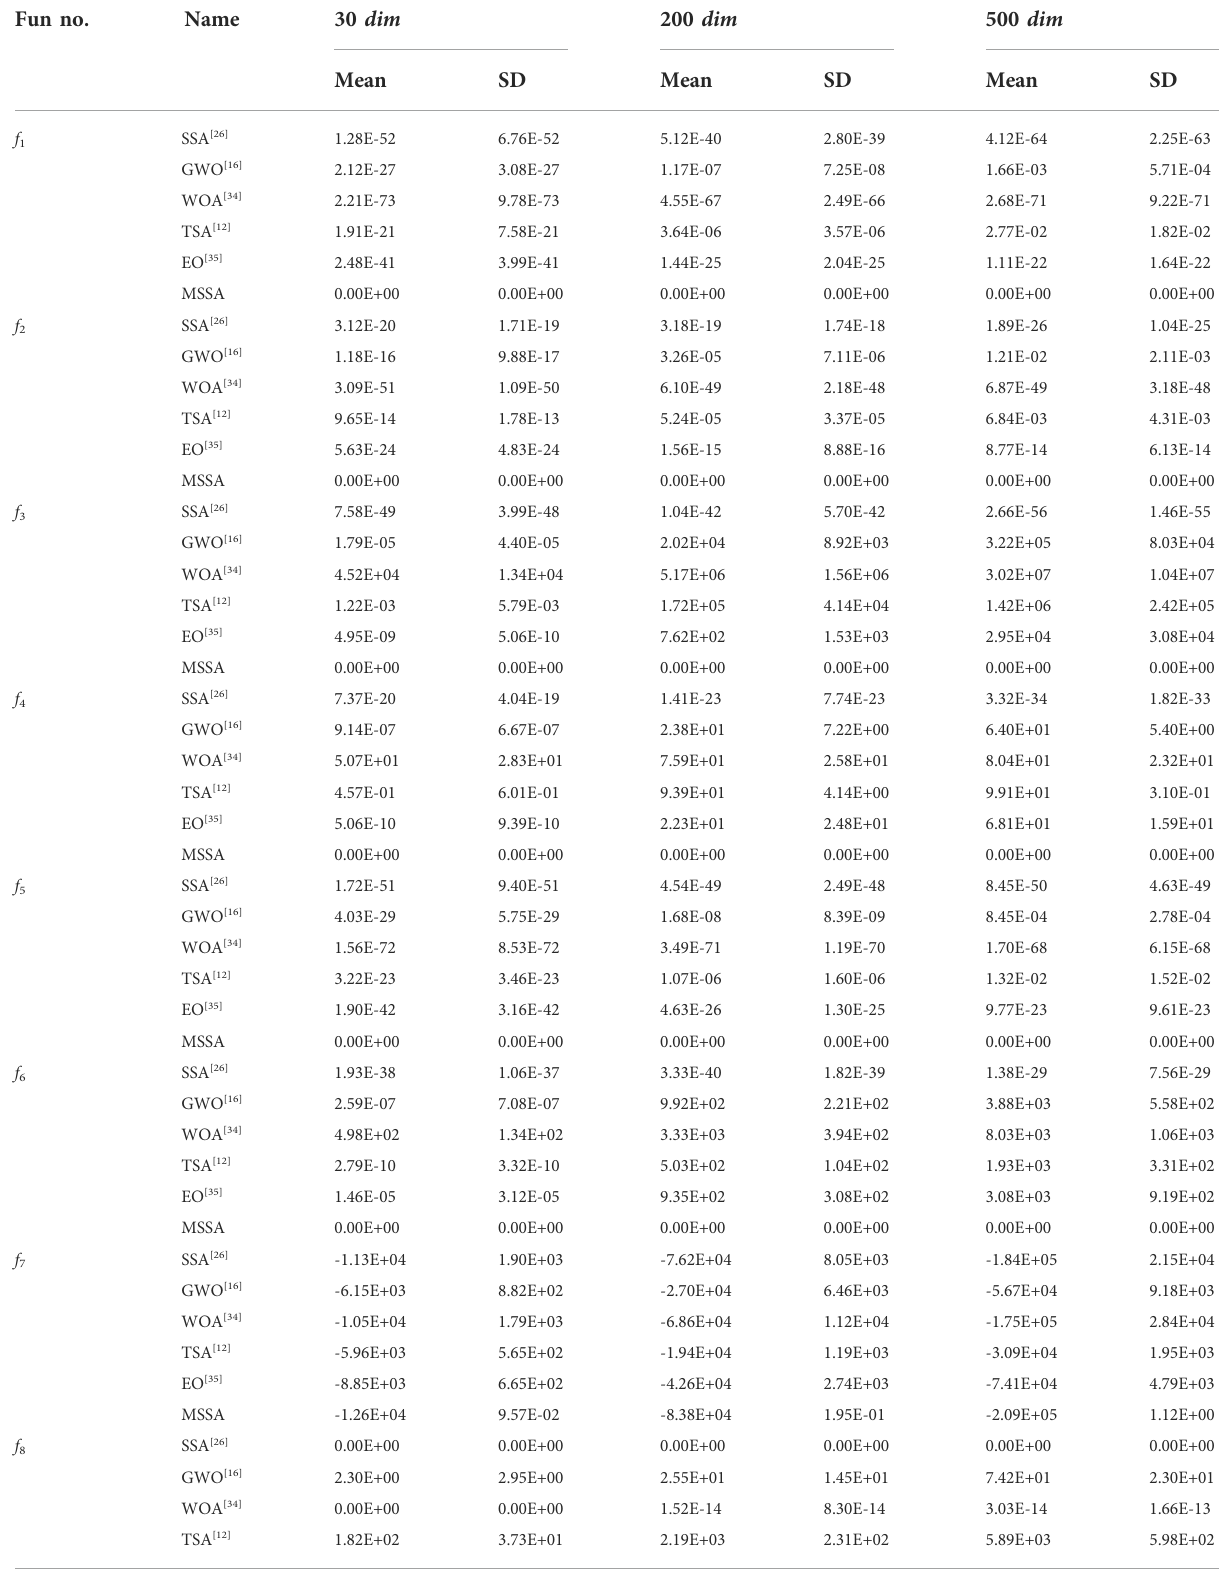
TABLE 3 Comparison with the results of fi ve metaheuristic algorithms. Fun